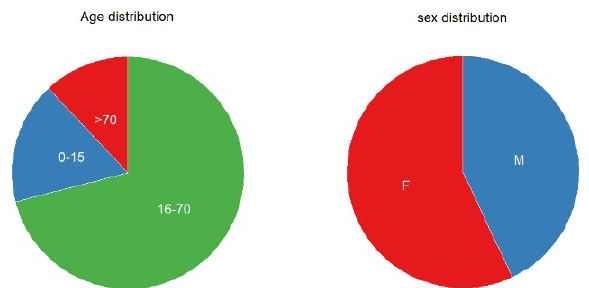
Figure 1. Distribution of the study sample according to age and gender. Figure 1 . Distribution of the study sample according to age and gender.